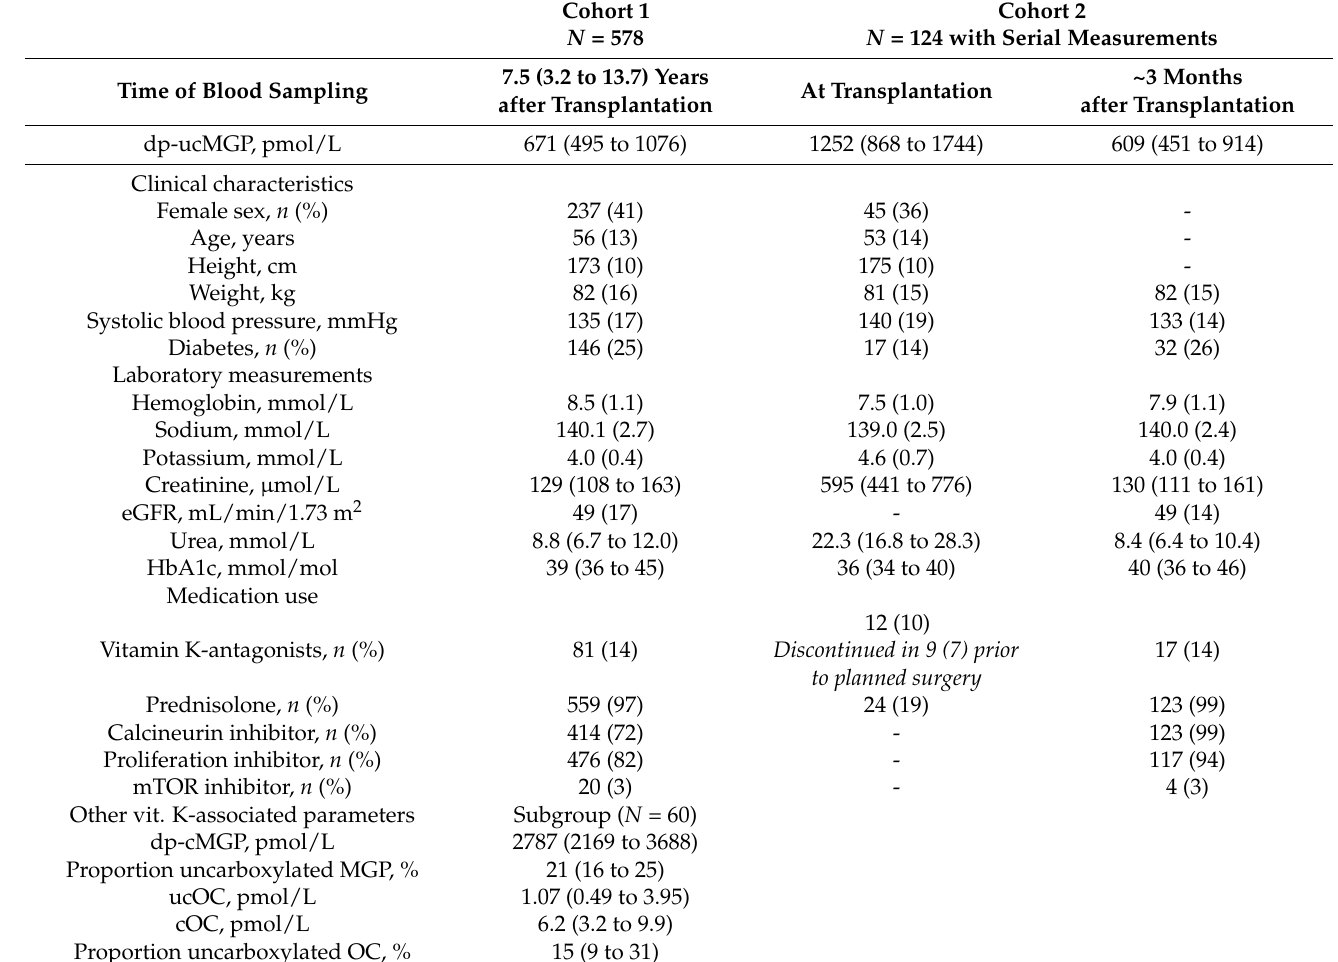
Table 1. Population characteristics at baseline for both cohorts.